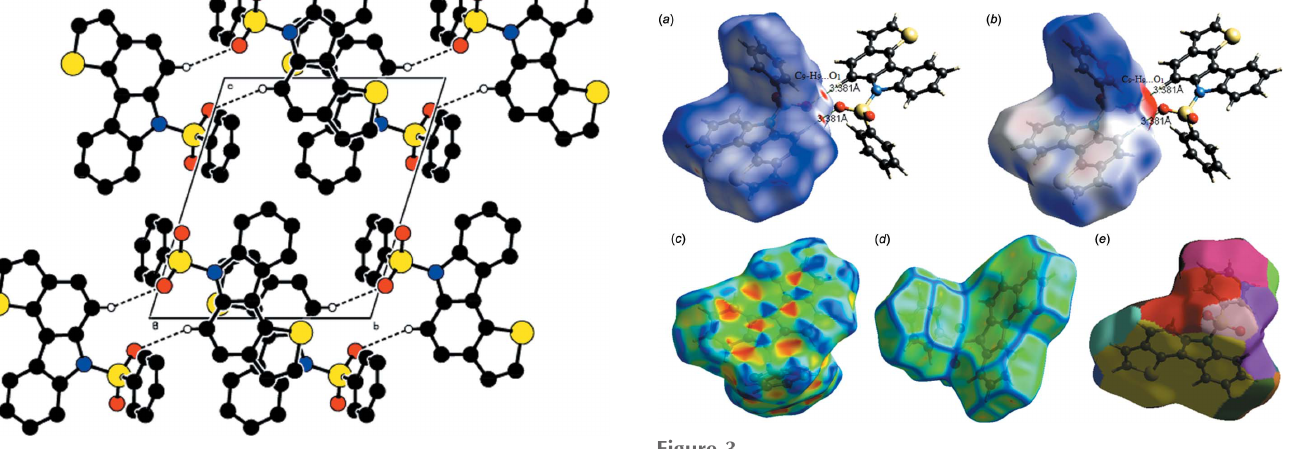
Figure 2 The crystal packing of the title compound, viewed along the a axis. Dashed lines indicate intermolecular hydrogen bonds. For clarity, only the H atoms involved in these interactions have been included.